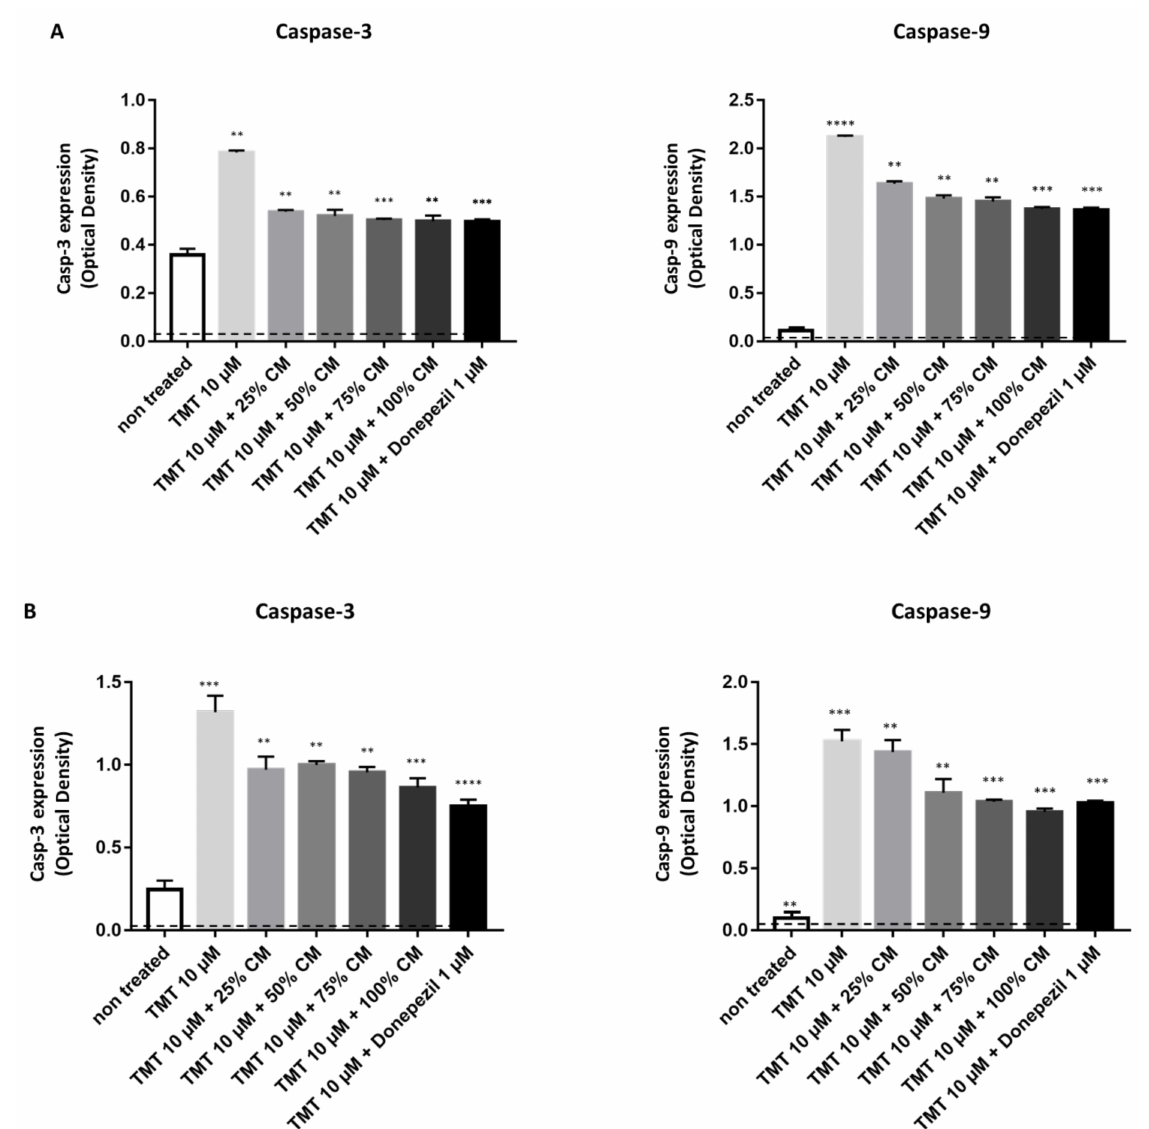
Figure 4. BUVEC-CM inhibits proapoptotic caspase-3 and caspase-9 production of rat pheochromo- cytoma PC12 and human neuron-like SH-SY5Y cell lines treated with TMT. To induce apoptosis, ( A ) rat pheochromocytoma PC12 and ( B ) human neuron-like SH-SY5Y cell lines were preincubated with 10 µ M TMT or equimolar TMT + increased BUVEC-CM concentration (25–100%) diluted in the respective cell line media. Untreated cells were used as a negative control. The analgesic agent Donepezil was used as a specific apoptosis inhibitor induced by TMT. A reduction in the apoptosis parameters, caspase-3 and caspase-9, was observed with ELISA of cytoplasmic lysate from PC12 and SH-sy5y cells treated with TMT and BUVEC-CM concentrations. Particularly, a dose-dependent reduction in caspase-9 concentration was observed in SH-SY5Y cells treated with TMT and increased BUVEC-CM concentration. Data are presented as optical density (OD) proportional to both cas- pase concentrations. A high OD represents high caspase production. ** p < 0.001, *** p < 0.0001, **** p < 0.00001 against untreated